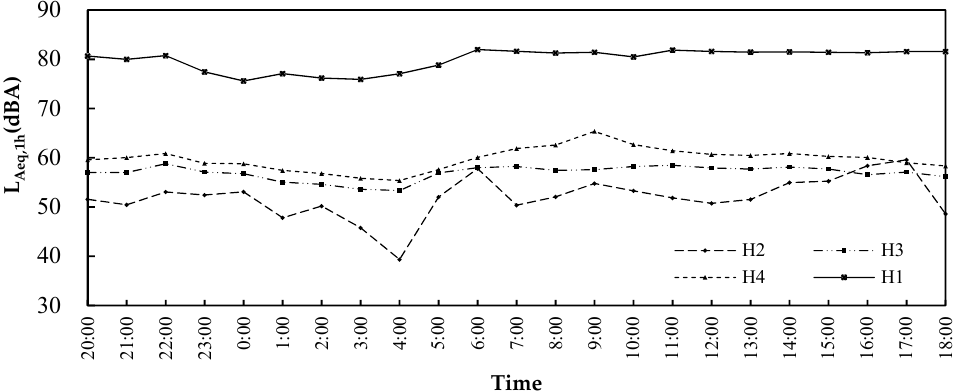
Figure 6. L Aeq,1h at four measuring points per hour.